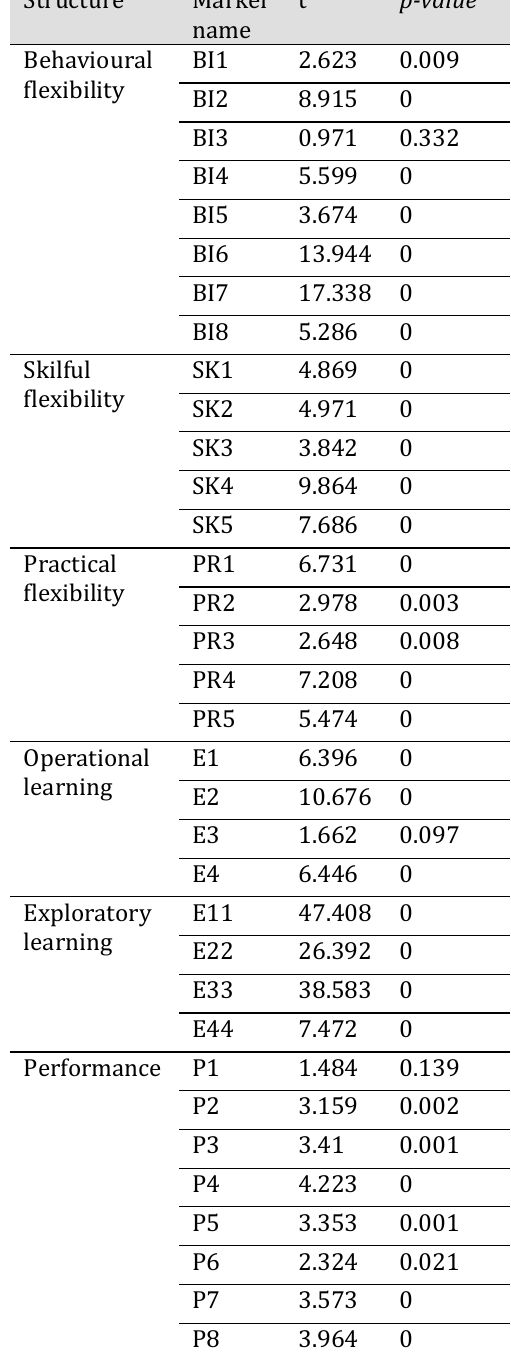
Table 1. Factor load values for each indicator